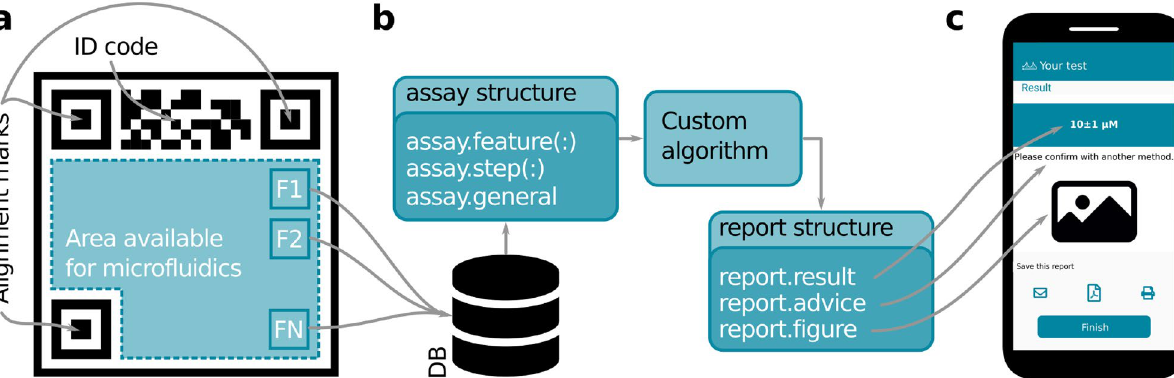
Figure 1. Elementary parts of appuente . ( a ) Microfluidic chip structures required by appuente . Besides alignment marks and ID code, the developer must define the features that will be used to obtain the test result. In this example, N features (F1, F2,...FN) were defined. ( b ) Inputs and outputs for the custom algorithm. The developer must provide a .m file with the desired algorithm. This algorithm will receive a data structure